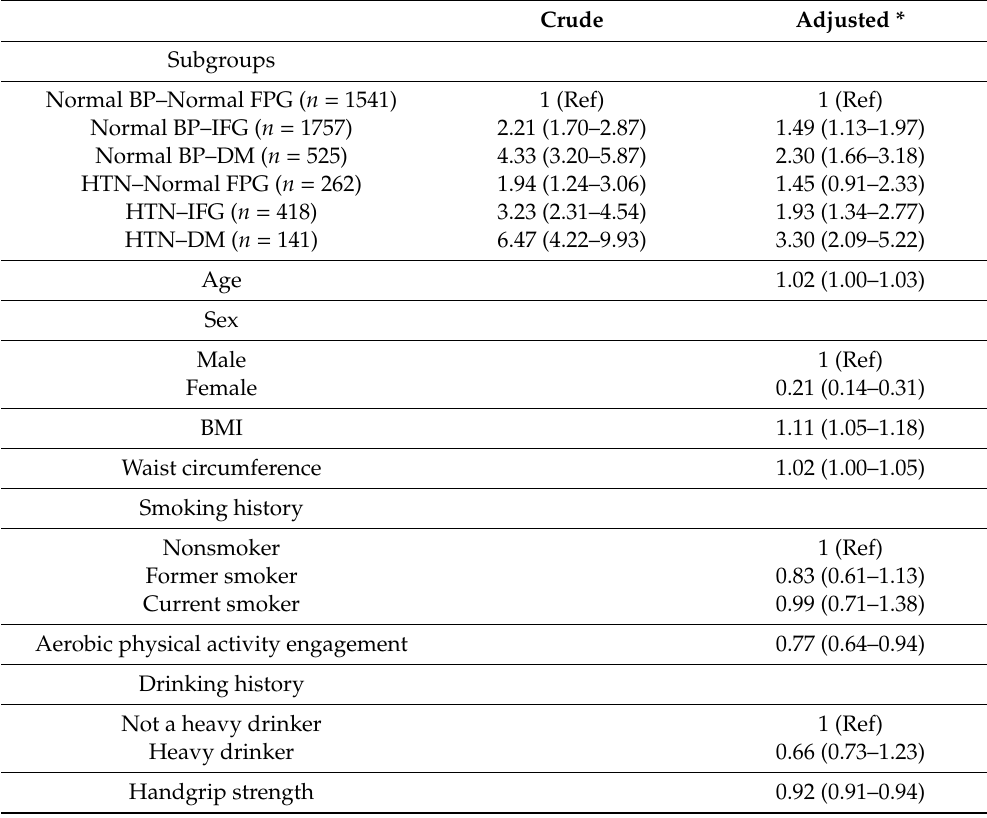
Table 3. Multivariate logistic regression model and odds ratio of restrictive lung disease (FVCp < 80%) according to hypertension, glycemic status, and other